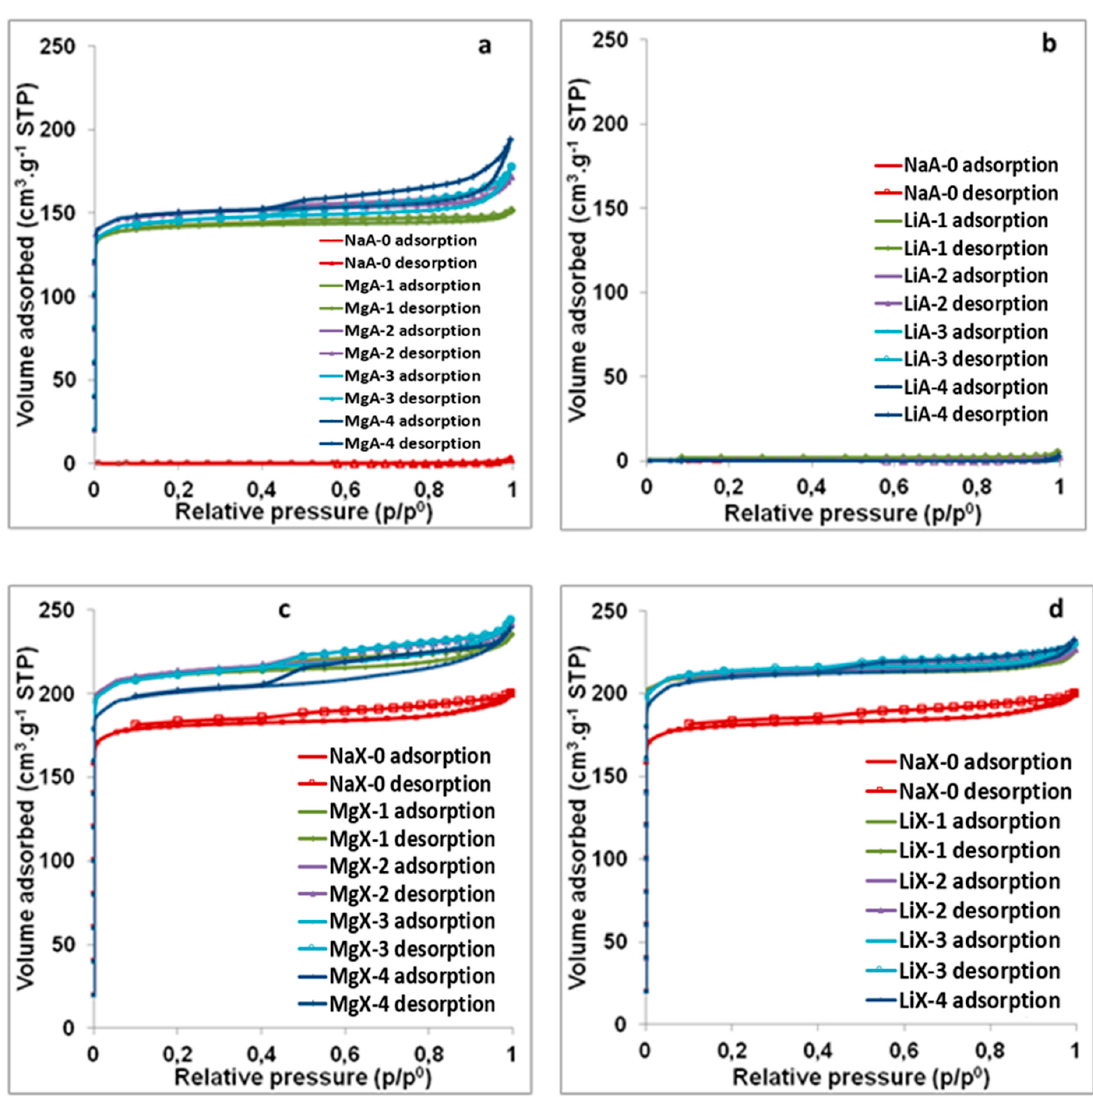
Figure A3. Nitrogen adsorption-desorption isotherms for raw and Mg 2 + exchanged LTA ( a ) and FAU ( c ) type zeolites and Li + exchanged LTA ( b ) and FAU ( d ) type zeolites.